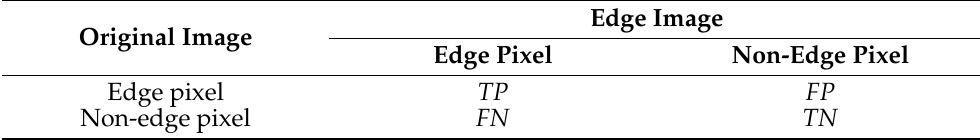
Table 3. Accuracy Matrix